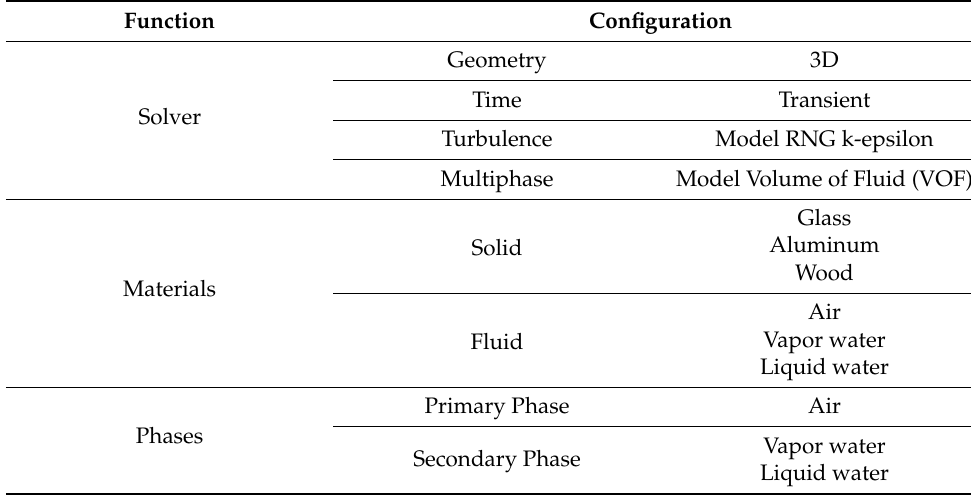
Table 6. Input parameters used in the CFD simulation.